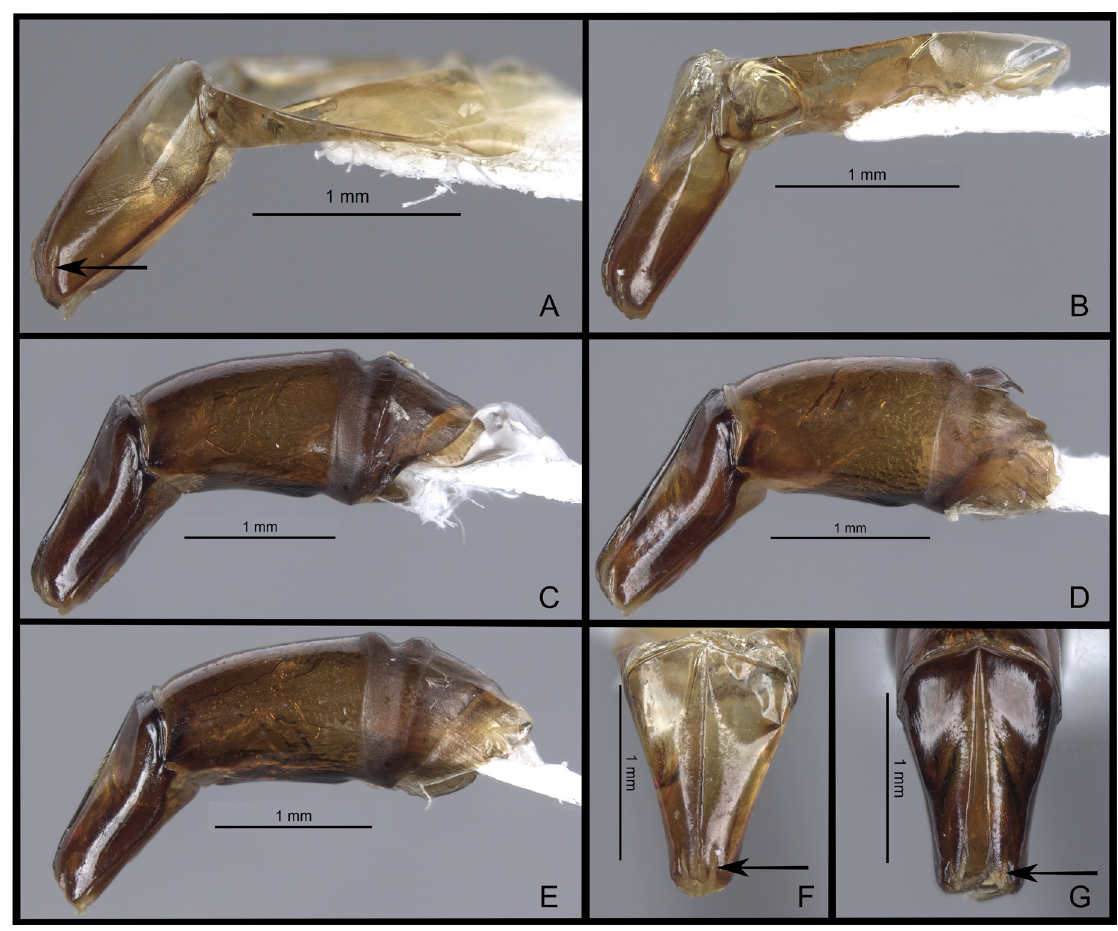
Fig. 7. Aedeagus of members of the gilli species group. A – E . Lateral view. F – G . Dorsal view of paramera. Arrows show the apical-dorsal notches of the paramera. A . Holotype of Deltochilum gilli González- Alvarado & Vaz-de-Mello, 2021, CNCI 379888. B . Holotype of D. jocelynae sp. nov., CNCI 379889. C . Holotype of D . nonstriatum sp. nov. CMNEN WSD00041746. D . Holotype of D . quasistriatum sp. nov., CMNEN WSD00041744. E . Holotype of D . tenuistriatum sp. nov., CMNEN WSD00041745. F . Holotype of D. jocelynae sp. nov. G . Holotype of D . nonstriatum sp. nov., CMNEN